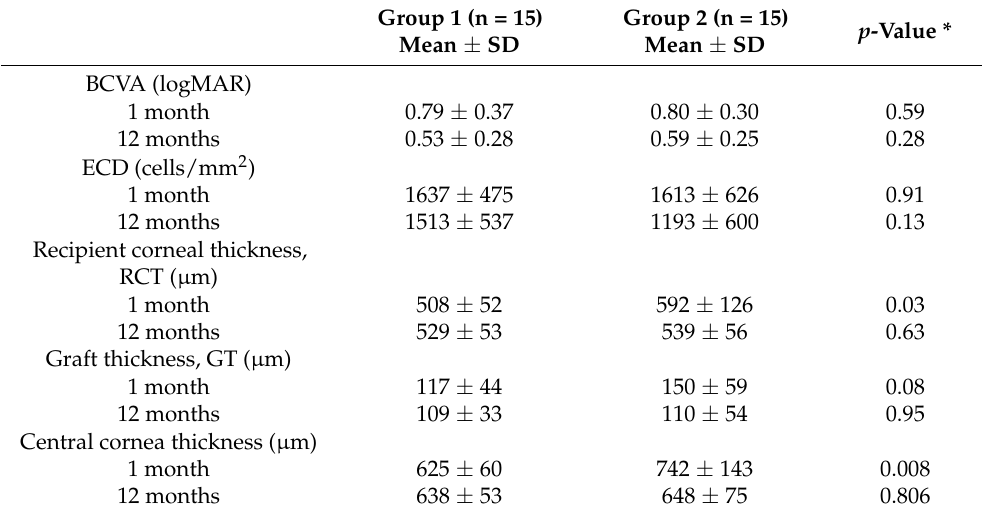
Table 2. Outcomes after DSAEK in patients with different preoperative cornea thickness at baseline.